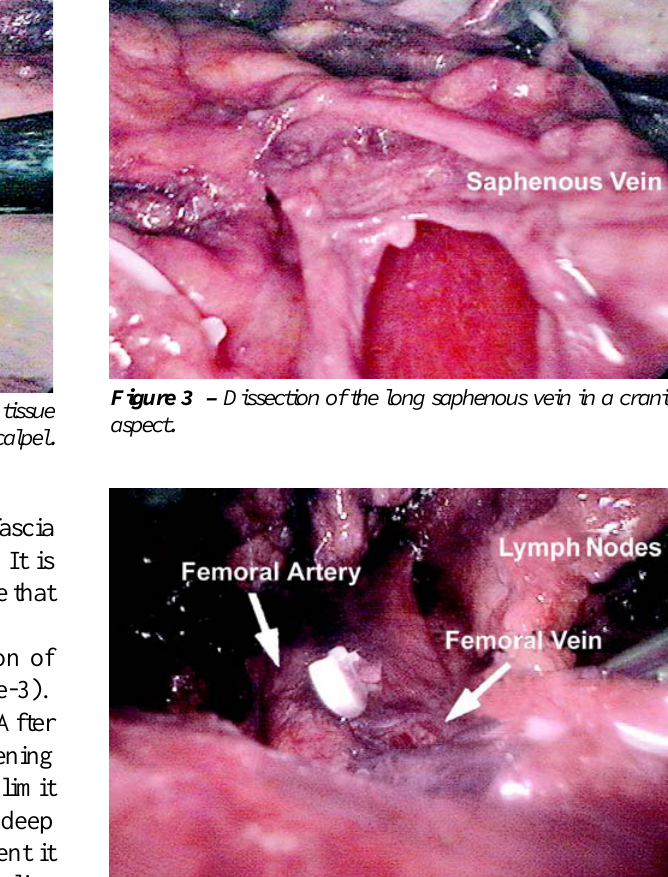
Figure 4 – Exposition of femoral artery and vein after the control of 3 small branches of the femoral artery that course anteriorly to the femoral